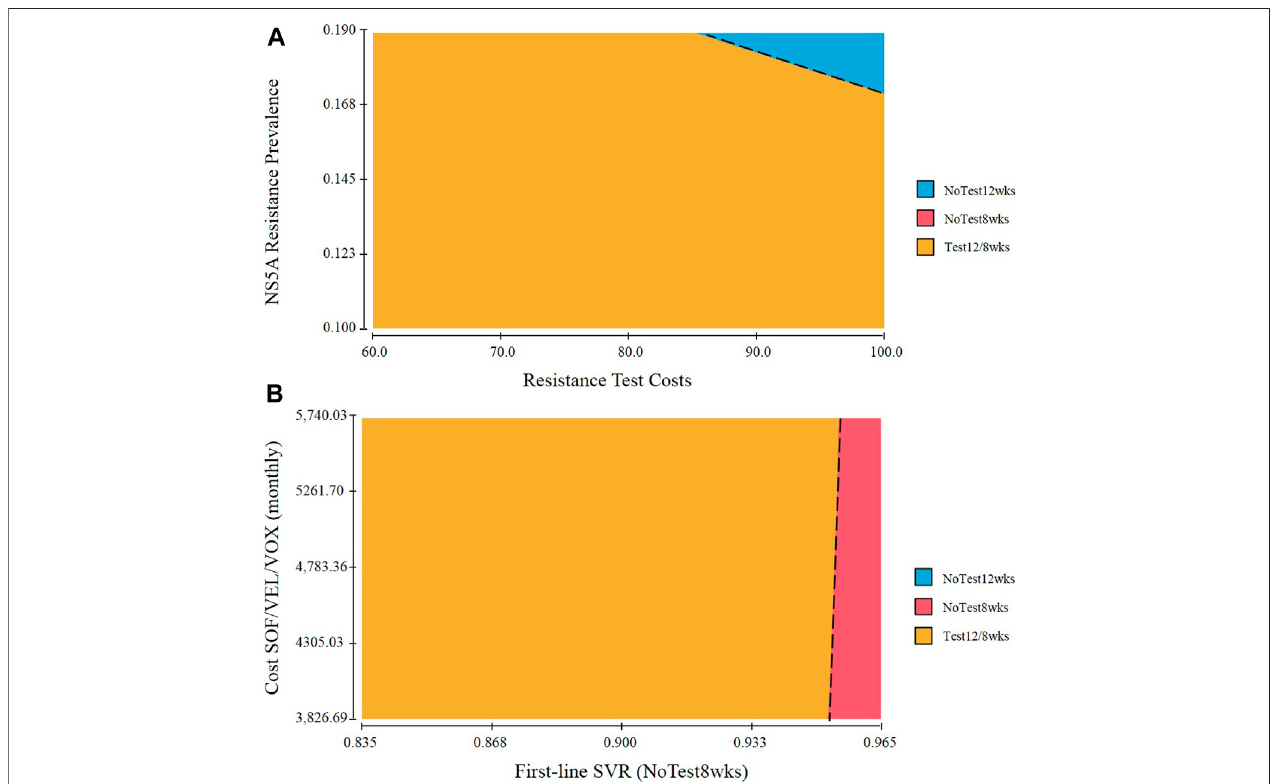
FIGURE 3 | Two-way sensitivity analysis of (A) NS5A resistance prevalence and resistance test costs. The dot line represents points at which performing NoTest 12 weeks and Test 12/8 weeks are equally cost effective. Combinations of input variables below and to the left of the line denote circumstances in which Test 12/ 8 weeks is the cost-effective approach and above and to the right favor NoTest 12 weeks (B) The probability of SVR in the NoTest 8 weeks strategy and the cost of second-line treatment.